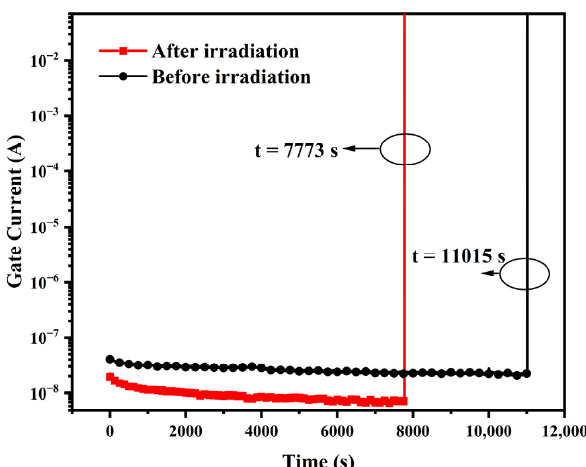
Figure 10. Comparison of TDDB breakdown application of sample devices before and after irradia- tion.